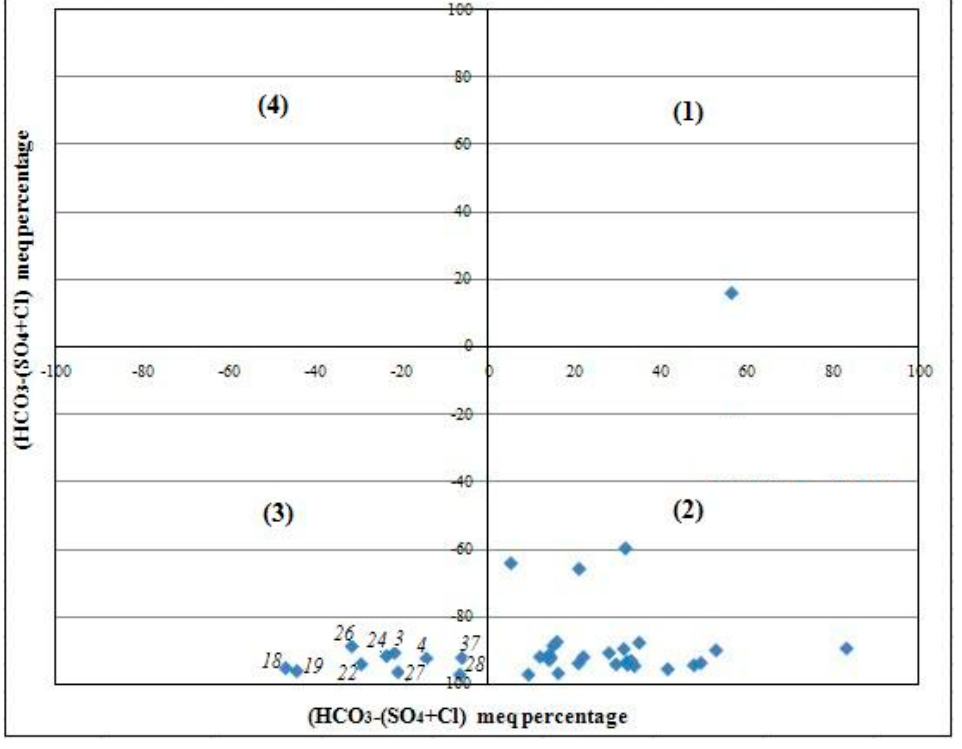
Figure 5. Chadha’s diagram in the Sfax coastal shallow aquifer: (1) recharge water, (2) reverse ion